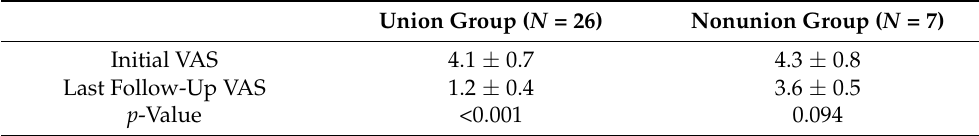
Table 3. Clinical outcomes using visual analog scale for neck pain in conservatively managed anterior tear drop fractures of